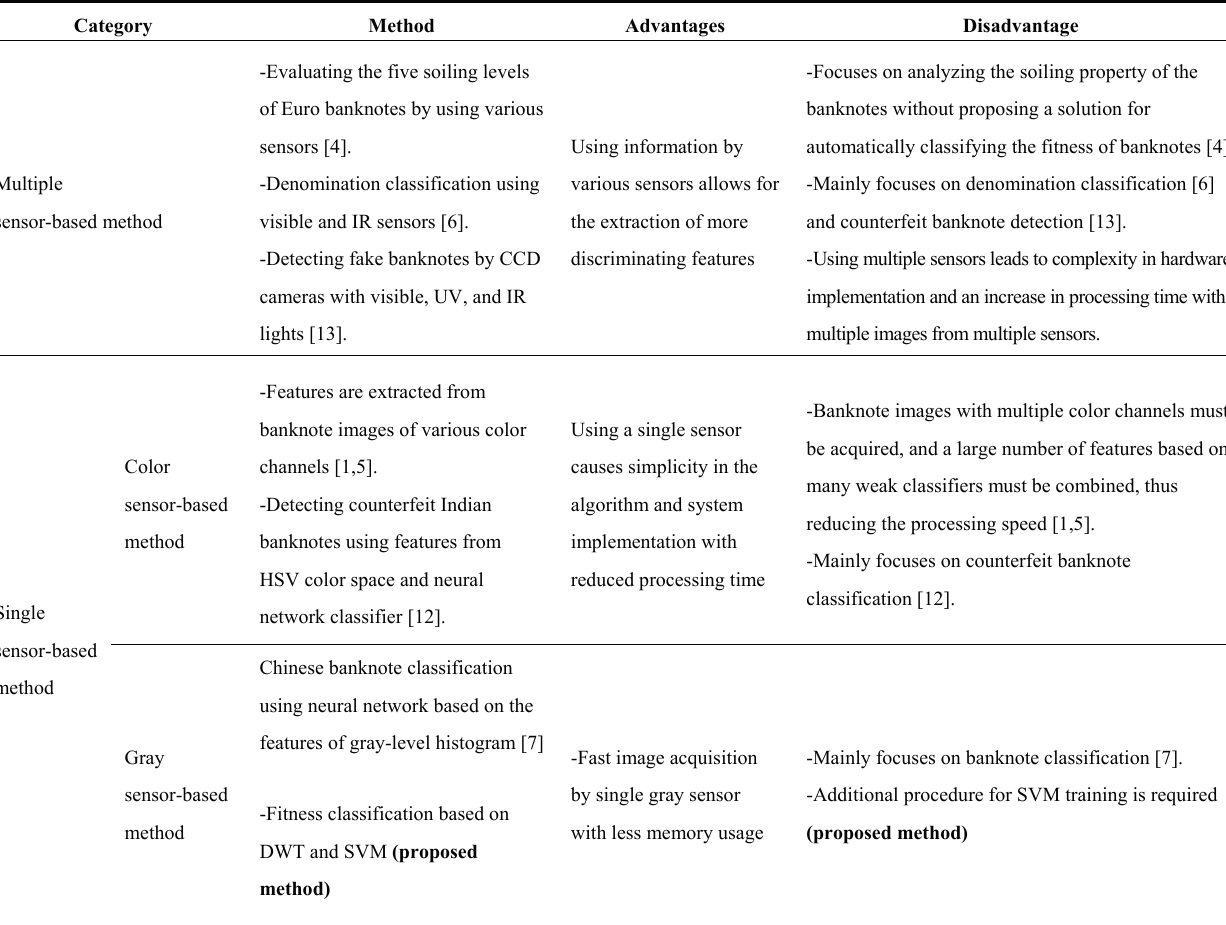
Table 1. Comparison of previous work and the proposed